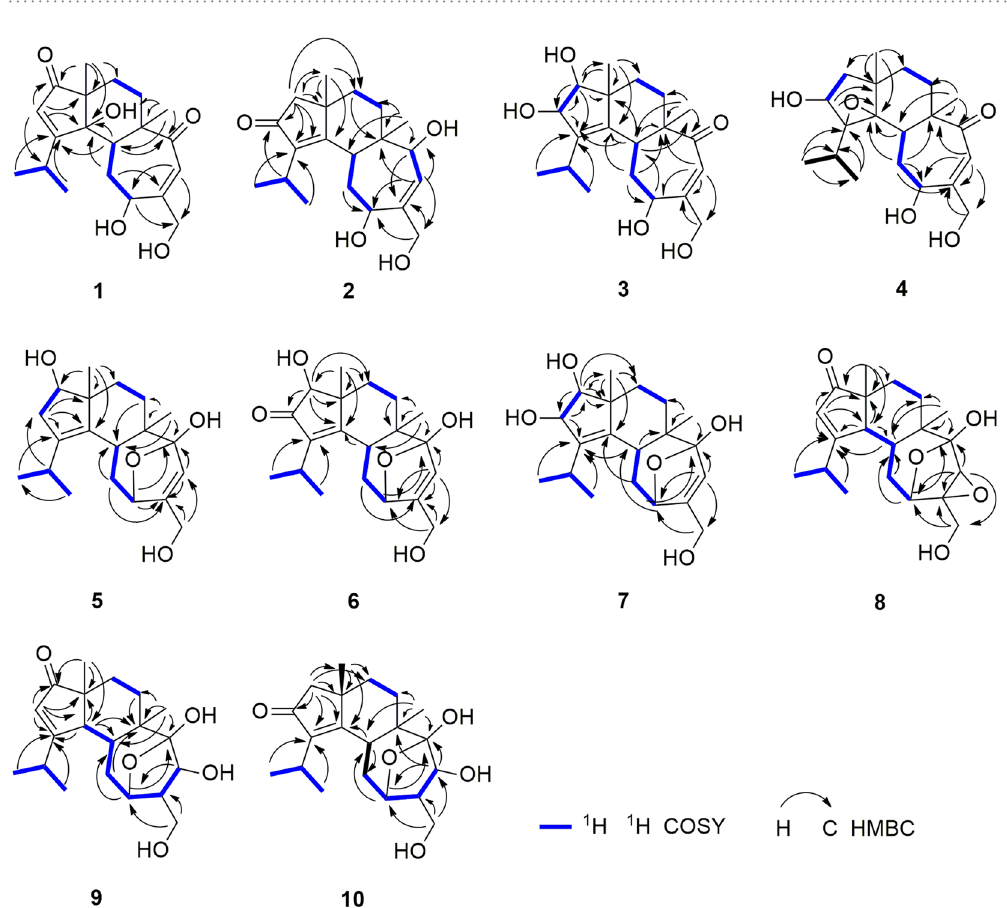
Figure 2. Key COSY and HMBC correlations of compounds 1 – 10